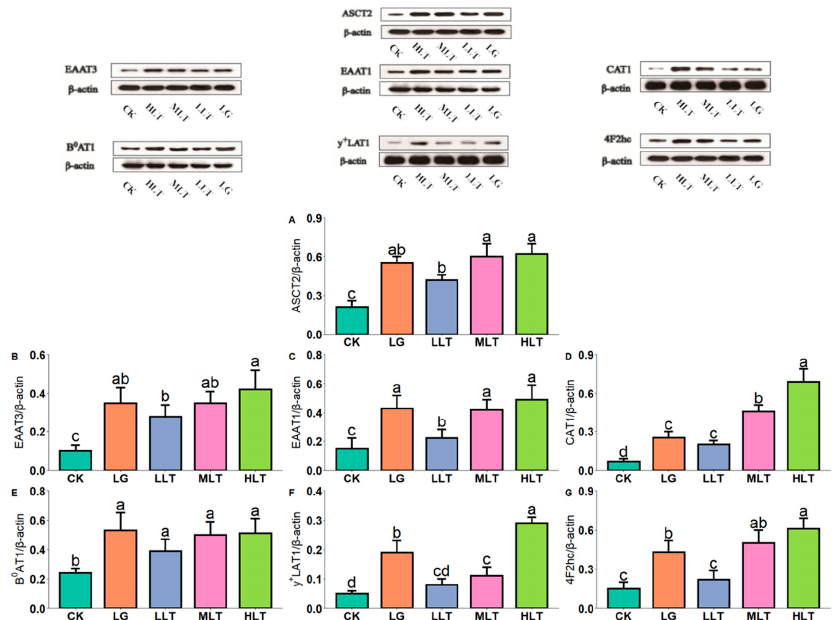
Figure 4. Effects of L-theanine on the protein expression of amino acid transporters of ( A ) ASCT2, ( B ) EAAT3, ( C ) EAAT1, ( D ) CAT1, ( E ) B 0 AT1, ( F ) y + LAT1, and ( G ) 4F2hc in the jejunum of mice. CK (control), HLT (LTA—400 mg • kg − 1 • d − 1 ), MLT (LTA—300 mg • kg − 1 • d − 1 ), LLT (LTA—100 mg • kg − 1 • d − 1 ), and LG (L-glutamine—300 mg • kg − 1 • d − 1 ) groups. Values are presented as mean ± SD; n = 3/group. Different superscript letters in the same figure indicate statistically signifi- cant differences ( p < 0.05).